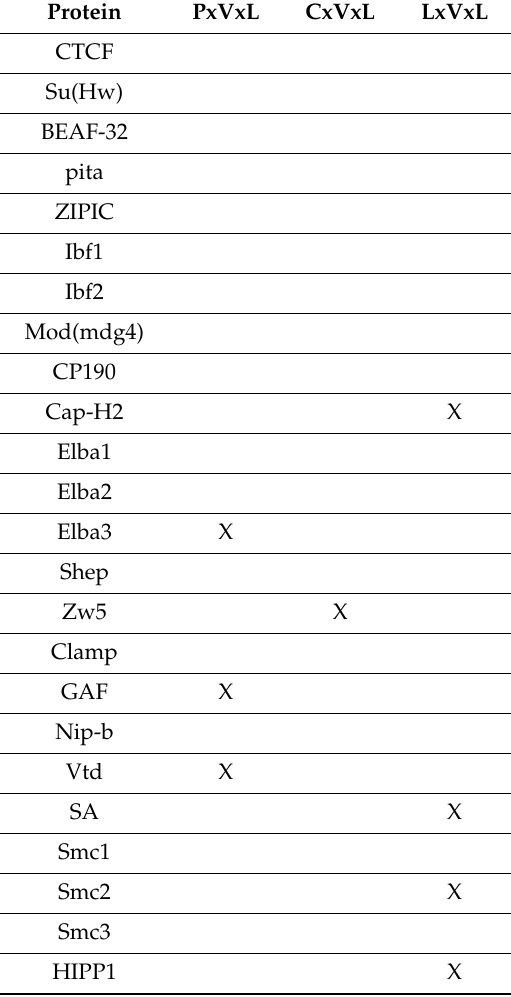
Table 3. Architectural proteins of Drosophila and motifs for possible interaction with HP1a